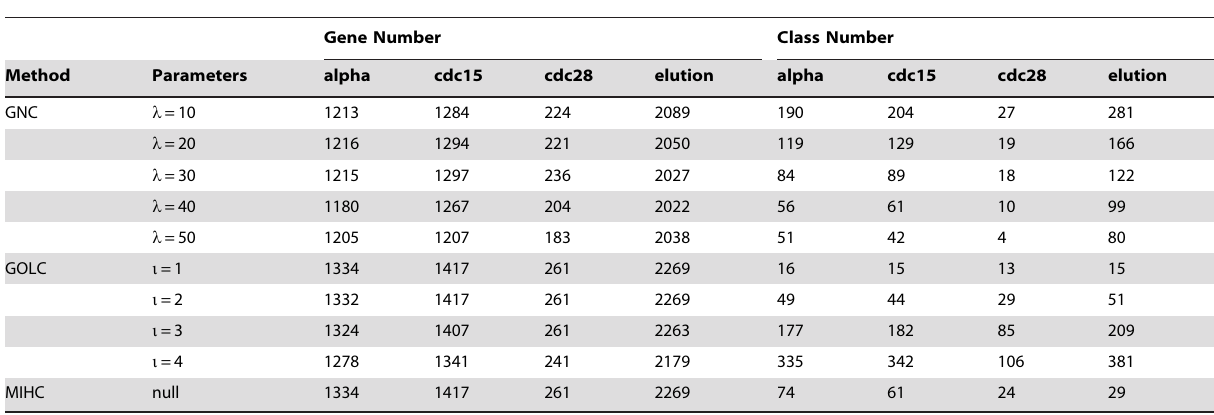
Table 1. Number of genes and classes in each learning system.